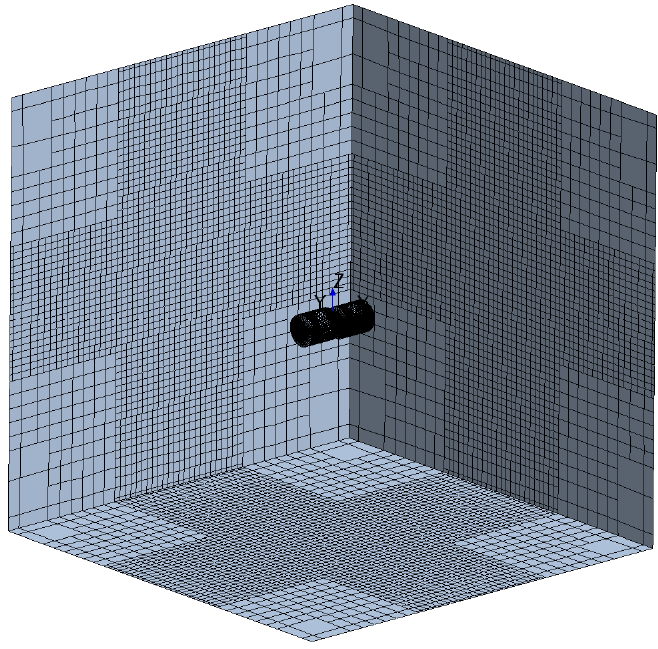
Figure 7. The background grids.